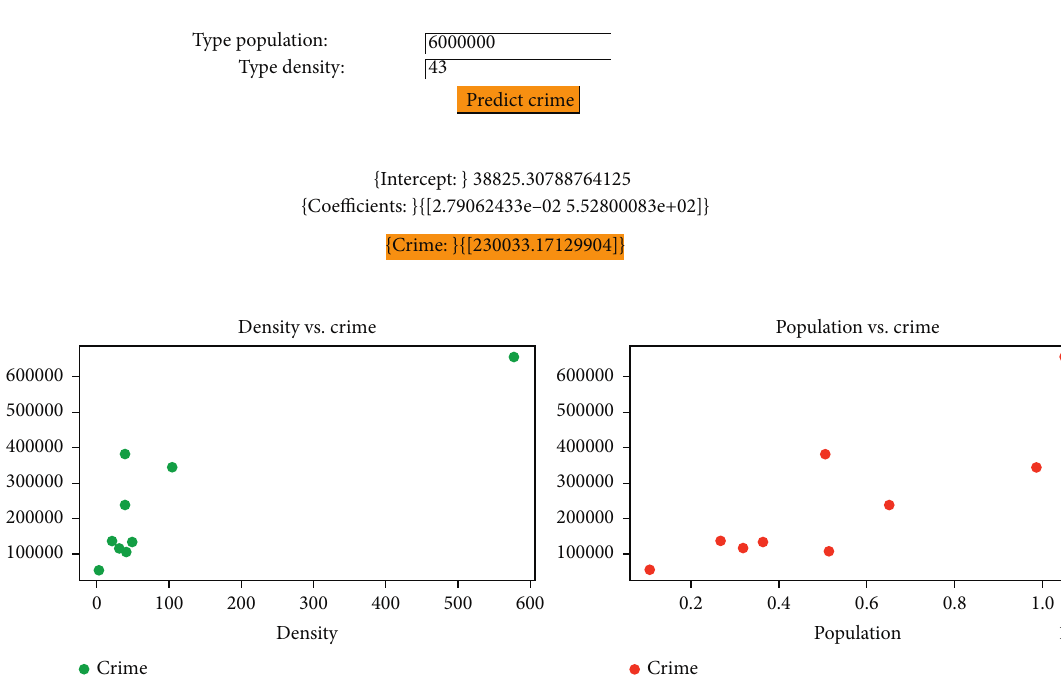
Figure 11: Crime prediction with linear regression